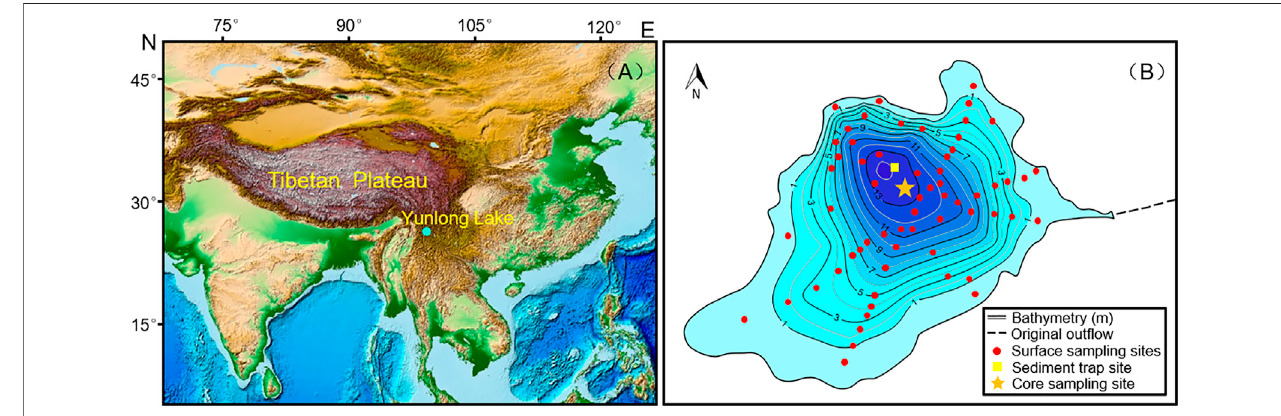
FIGURE 1 | Location of Yunlong Lake and sampling sites. (A) Schematic diagram of the geographical location of Yunlong Lake. (B) Bathymetry of Yunlong Lake and the locations of the surface samples, sediment core, and sediment trap.